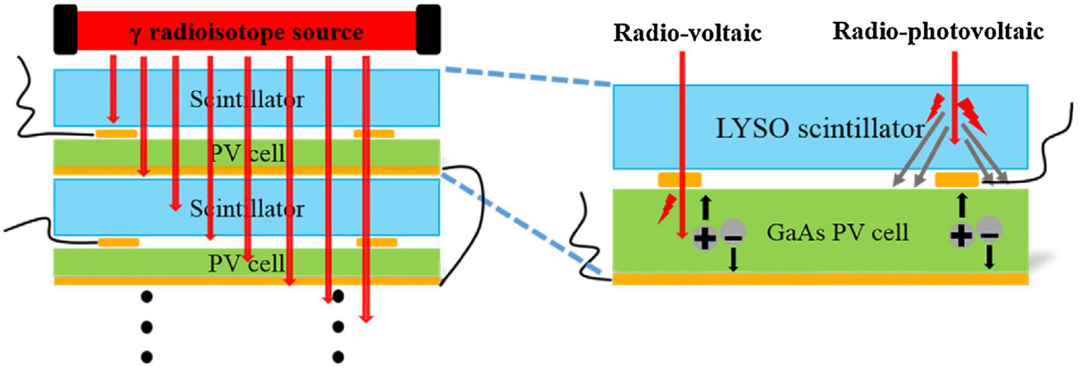
Figure 10. Schematic of the dual ‐ effect multi ‐ level isotope battery. Copyright permission from [131].